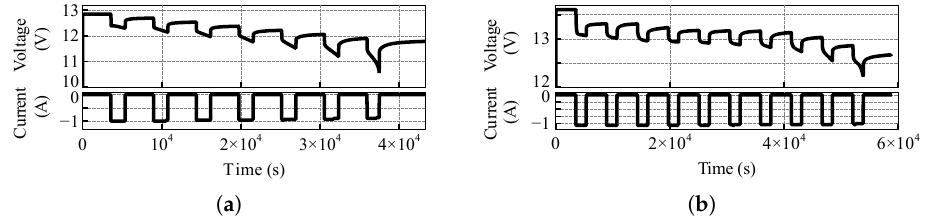
Figure 3. Pulse discharge test data from the batteries used in this work: ( a ) SLA battery pack. ( b ) LFP battery pack.